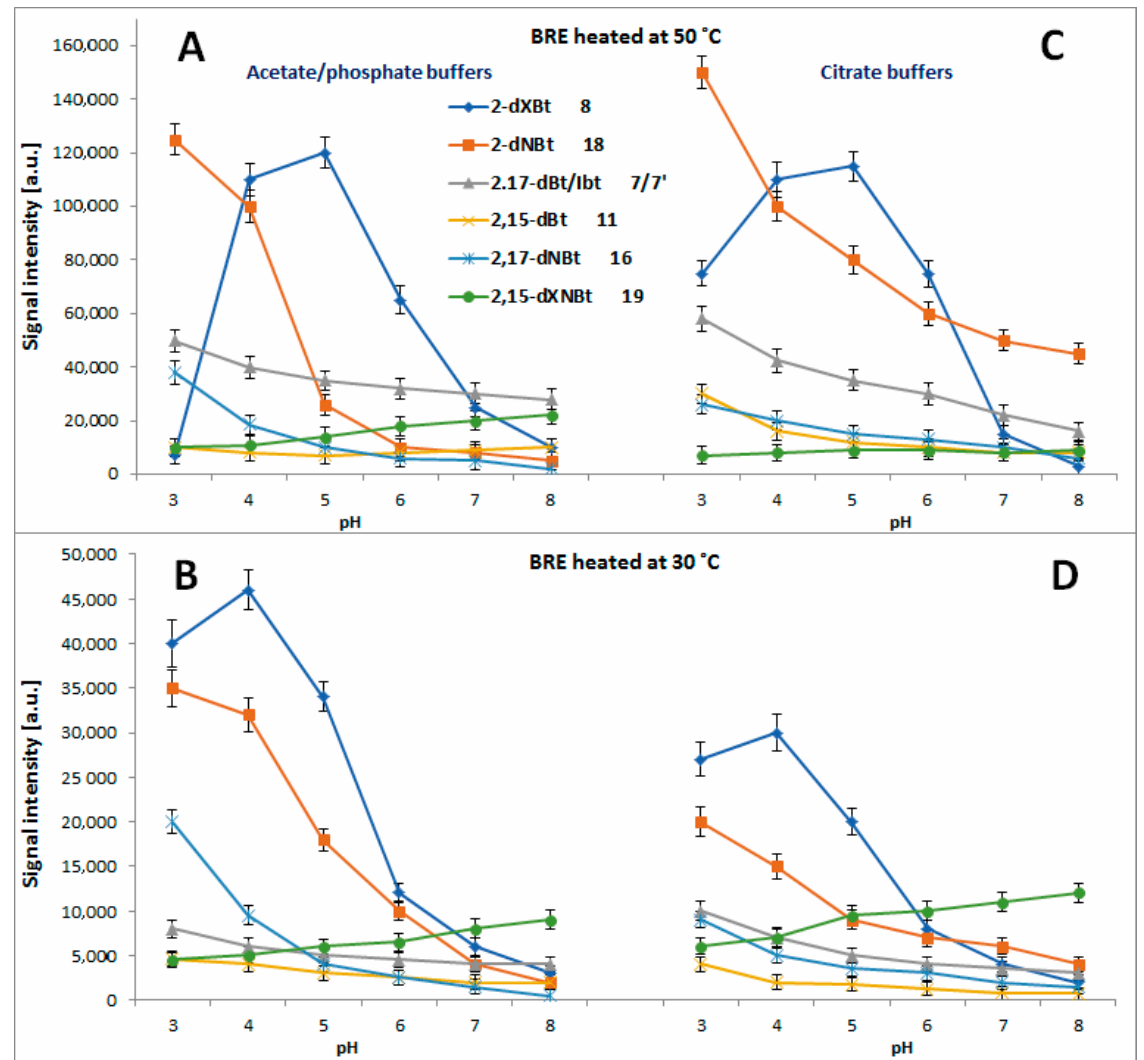
Figure 13. LC ‐ MS signal levels of prominent bi ‐ decarboxylated betanin derivatives ( 7/7 ′ and 11 ) and dehydrogenated betanins ( 8 , 16 , 18 , and 19 ) detected after 5 h ( A , C ) and 3 days ( B , D ) extract heating at 50 and 30 °C, respectively, in acetate/phosphate ( A , B ) and citrate ( C , D ) buffer solutions in dependence on pH.